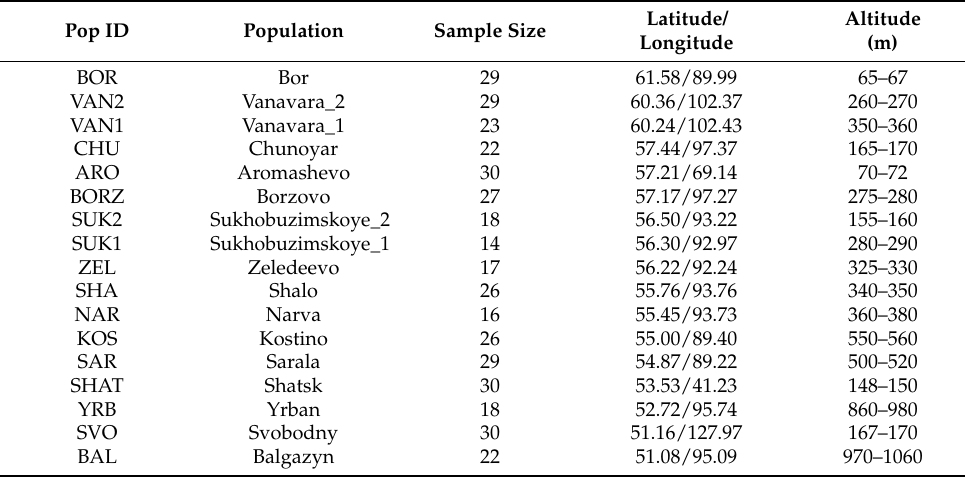
Table 1. Geographic location of 17 Scots pine populations across